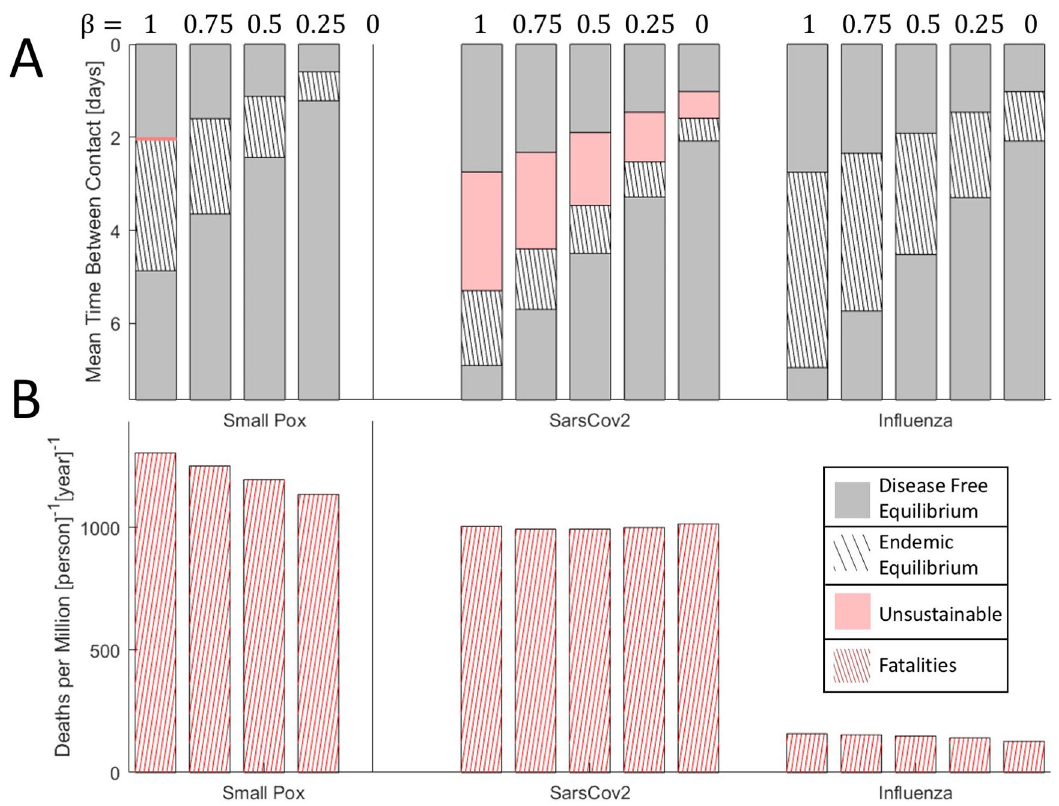
Figure 5. The effects of isolation on epidemic evolution. A. Disease free equilibrium (gray), endemic equilibrium (striped), and unsustainable (red) regions for three viruses over a range of host contact rates. Red region for smallpox-like viruses is narrow and not shown to scale. Bars are ordered by decreasing β ∈ {0,0.25,0.5,0.75,1}. B. Death rate at endemic equilibrium (contact rates correspond to the midrange shown in A). Bars are ordered by decreasing β ∈ {0,0.25,0.5,0.75,1}. Note that, representing equilibrium, the choice of timescale (years) is